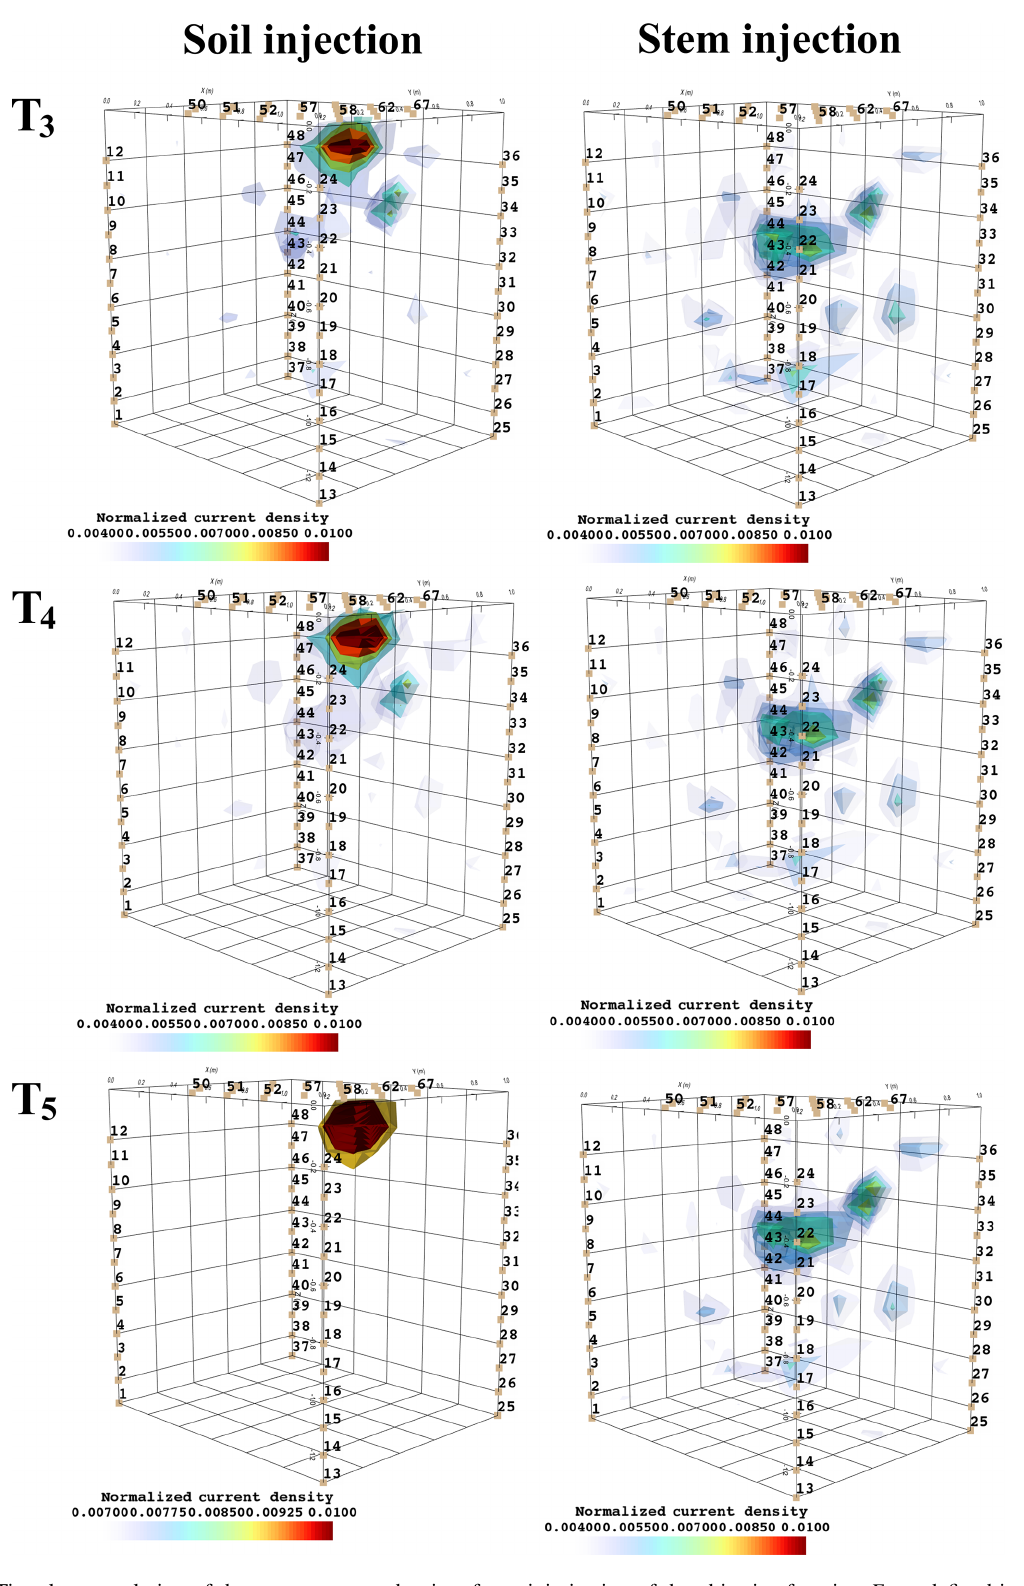
Figure C4. Time-lapse evolution of the current source density after minimization of the objective function F 2 as defined in Eq. (3). The results are relevant to the background time T 0 to T 5 for plant B, for the soil current injection on the left and stem current injection on the